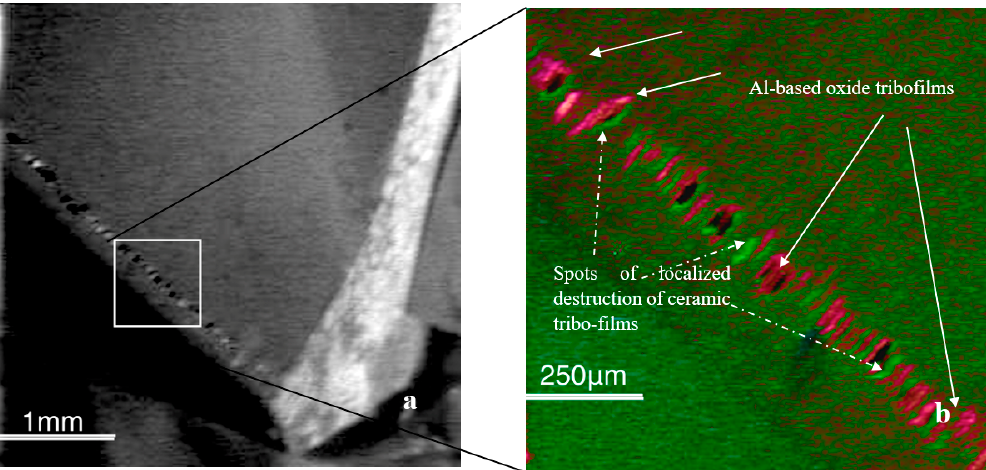
Figure 1. Auger image of atomic-scale tribo-films forming on worn surface ( a )—a general image (topography contrast); ( b )—red image, tribo-films; light green image, coating layer [11].